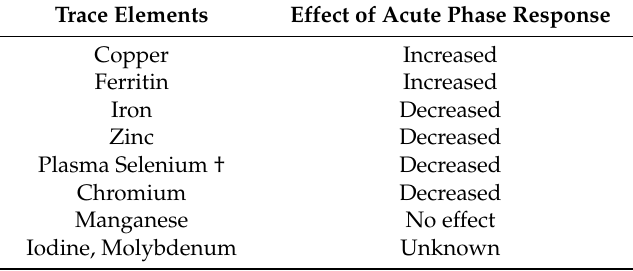
Table 4. Impact of acute phase response on serum trace elements levels. Trace